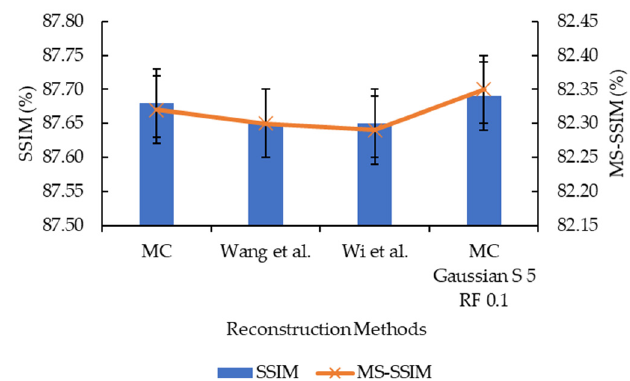
Figure 19. Graph of SSIM and MS-SSIM against different reconstruction methods.